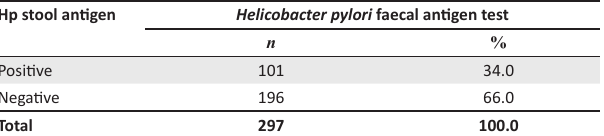
TABLE 5: Pre-treatment Helicobacter pylori faecal antigen test.